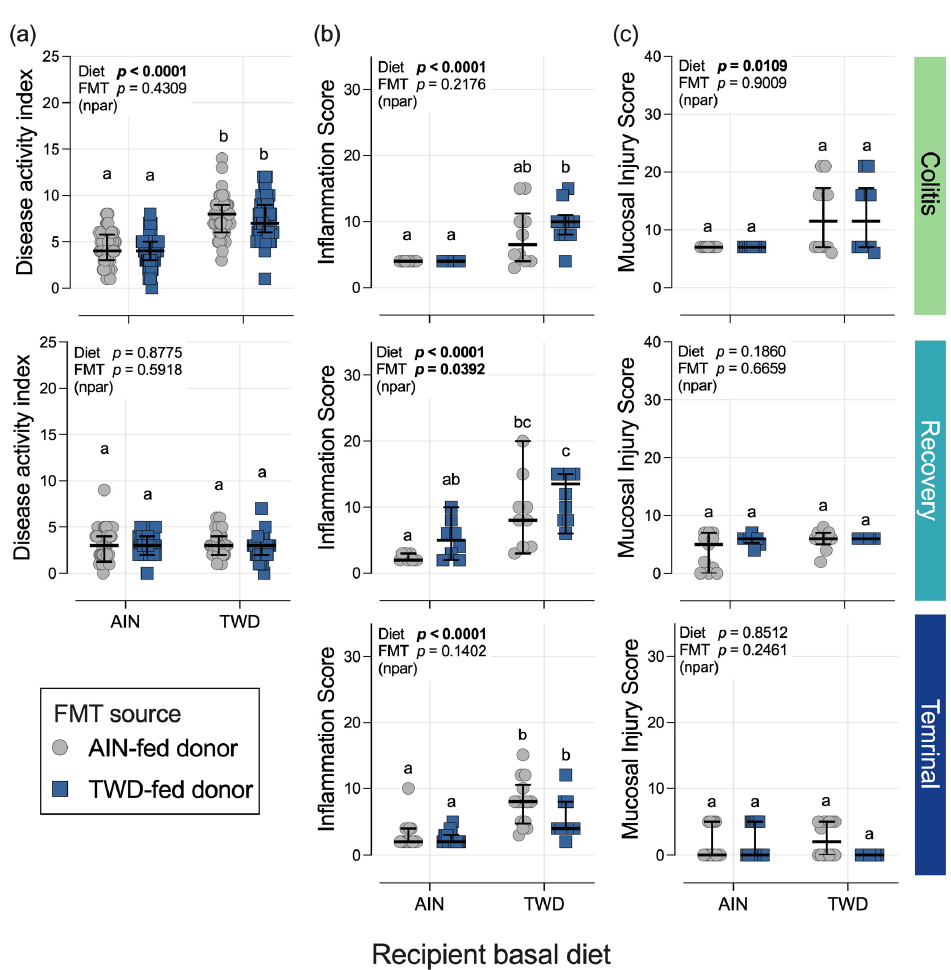
Figure 2. Disease activity index and colon histopathology. Scores for the disease activity index (DAI) ( a ), mucosal inflammation ( b ), and mucosal injury ( c ) are shown for active colitis on day 26, for recovery from gut injury on day 38, and for the terminal time point on day 112. The data are shown as individual values with median ± interquartile range. For the DAI score, n = 53 to 64 mice per group at the active colitis time point and n = 37 to 44 mice per group at the recovery time point. For inflammation and mucosal injury scores, n = 10 to 11 mice per group at the active colitis time point, n = 7 to 11 mice per group at the recovery time point, and n = 10 to 16 mice per group at the terminal time point. The inserted values provide the statistical model’s main effects for recipient basal diet and FMT source, and their interaction, or “npar” if a non-parametric test was required, and different letters indicate that the experimental groups are significantly different ( p < 0.05), as determined by the statistical methods outlined in the Materials and Methods section.